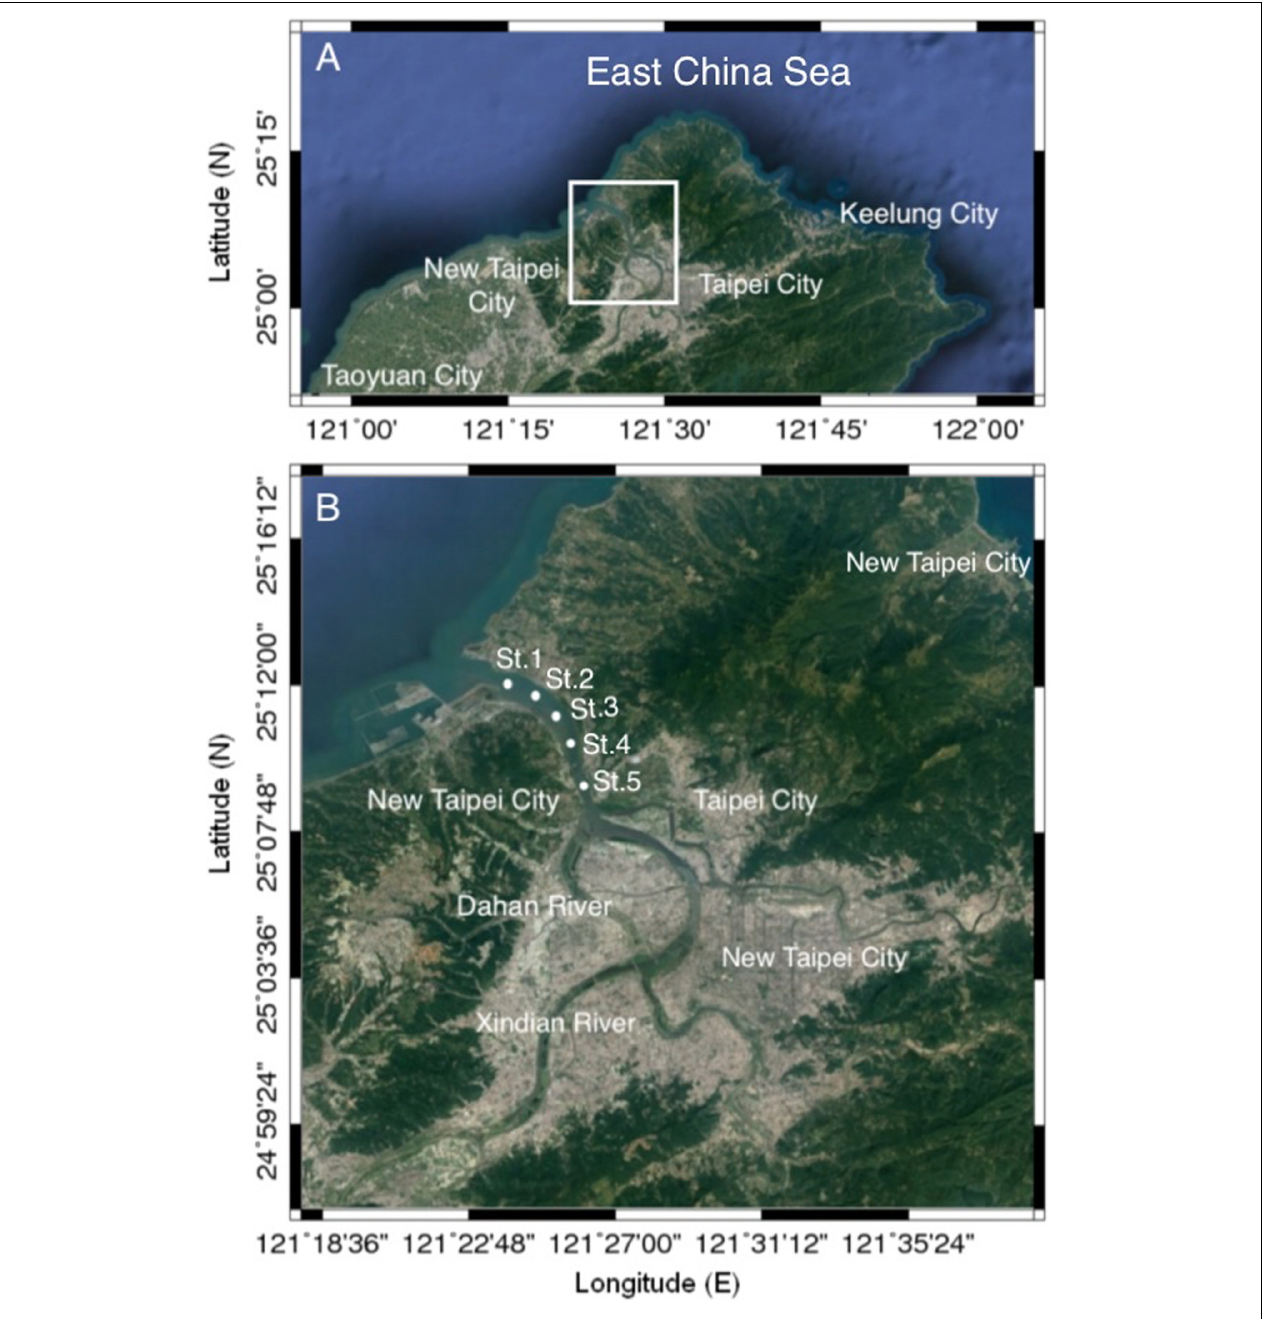
FIGURE 1 | Maps of the study area (A) and the locations of the sampling stations (B) in the estuary of the Danshuei River in northwestern Taiwan.